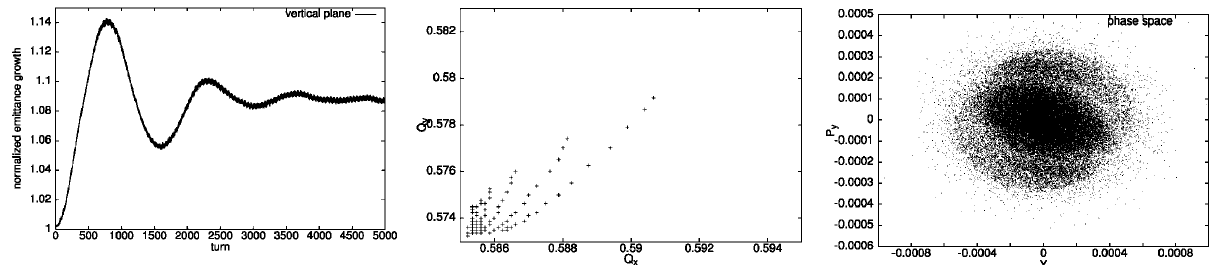
FIG. 4. The vertical normalized emittance growth of the weak beam (left panel), the tune spread of the weak beam with initial maximum 5 (cid:22) amplitude range (middle panel), and the vertical phase space distribution after 1000 turns (right panel), with an initial 20% mismatch of the strong beam and 0.002 lower machine tune of the weak beam.